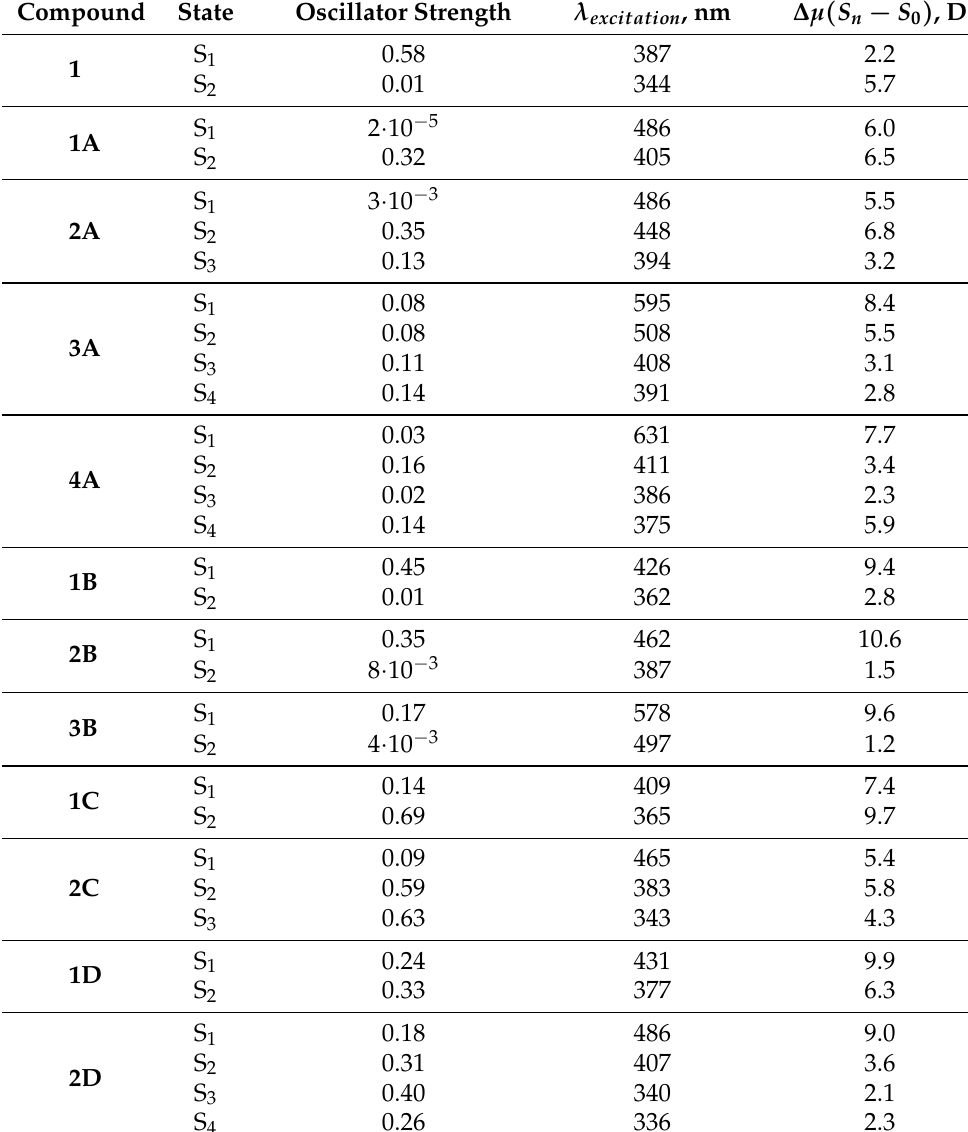
Table 2. Calculated photophysical properties for the S 0 – S n transitions in compound 1 and its derivatives from classes A , B , C , and D in the gas phase. Compound State Oscillator